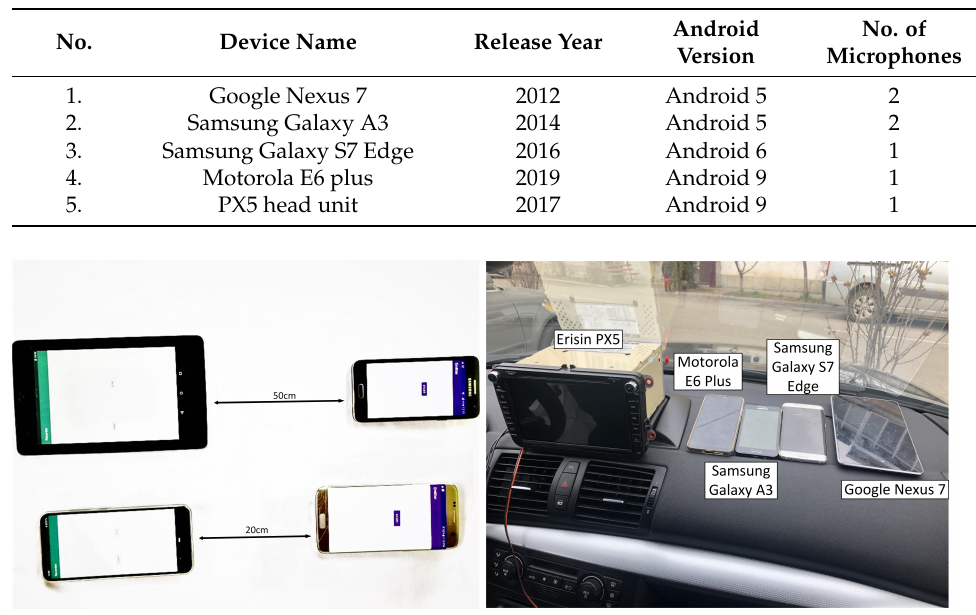
Table 2. Devices from our experiments.